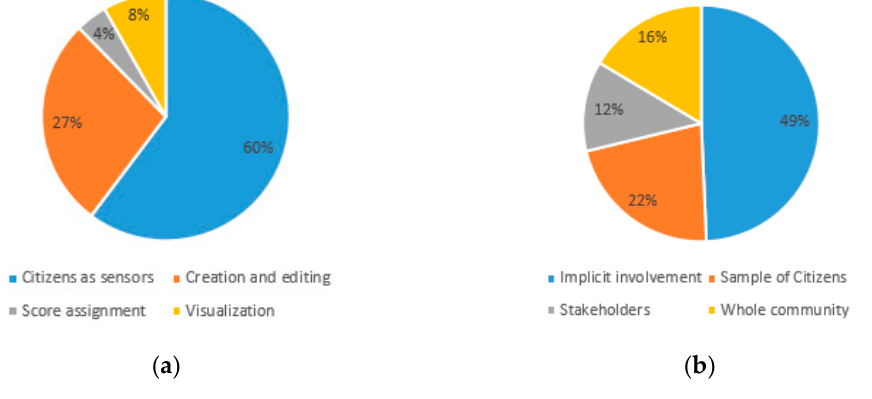
Figure 4. ( a ) Role of GIS; ( b ) Type of Involvement.